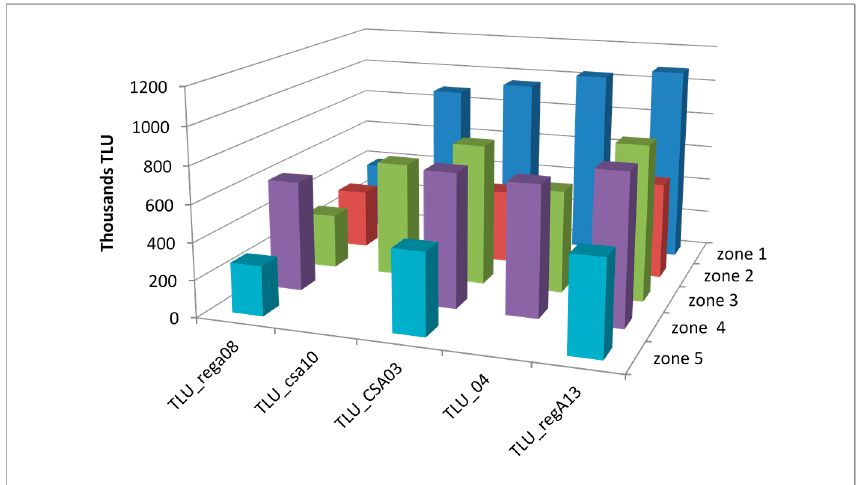
Figure 5. TLU by zone and data source.